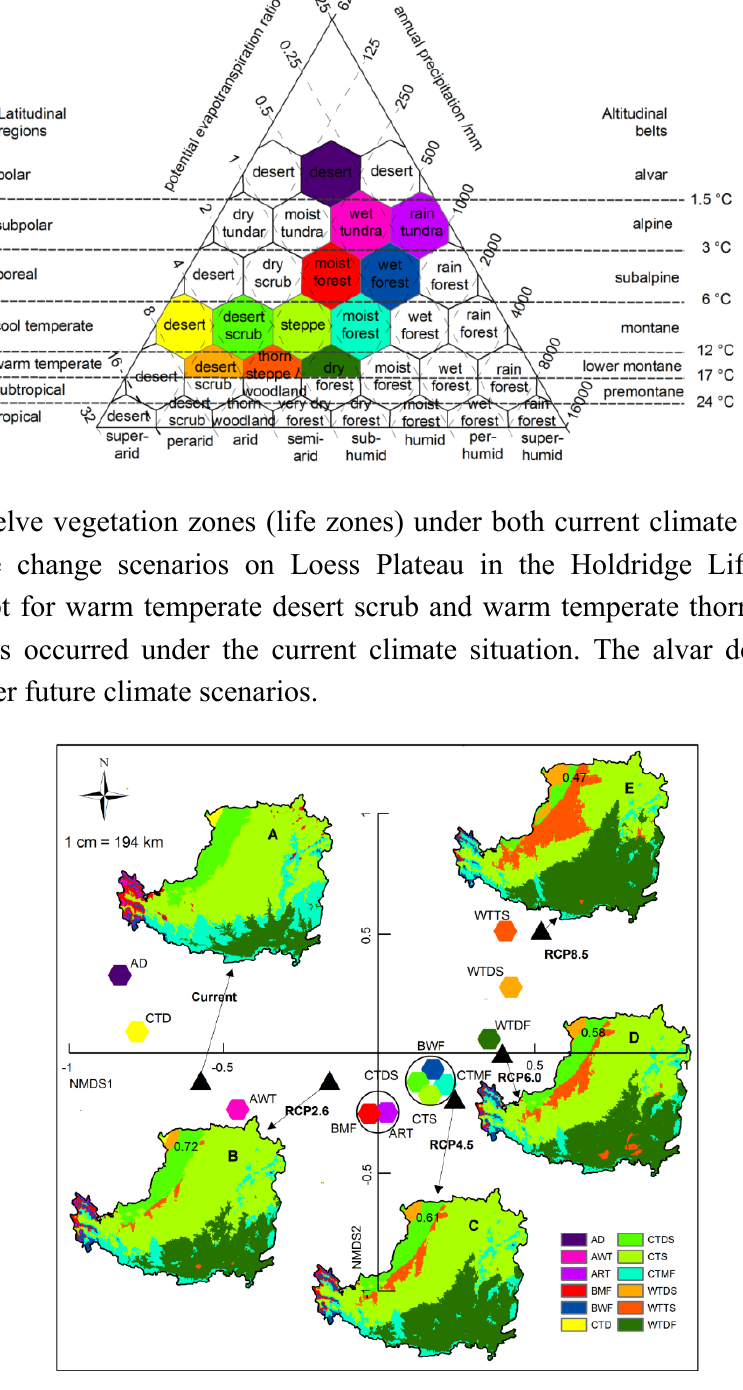
Figure 4. NMSD ordinations of vegetation structure under current and future climate scenarios on Loess Plateau and Pearson coefficients between current and future vegetation map (shown in the left-corner of each submap). ( A ) current climate; ( B ) RCP2.6; ( C ) RCP4.5; ( D ) RCP6.0; ( E ) RCP8.5. Alvar desert (AD), alpine wet tundra (AWT), alpine rain tundra (ART), boreal moist forest (BMF), boreal wet forest (BWF), cool temperate desert (CTD), cool temperate desert scrub (CTDS), cool temperate steppe (CTS), cool temperate moist forest (CTMF), warm temperate desert scrub (WTDS), warm temperate thorn steppe (WTTS), and warm temperate dry forest